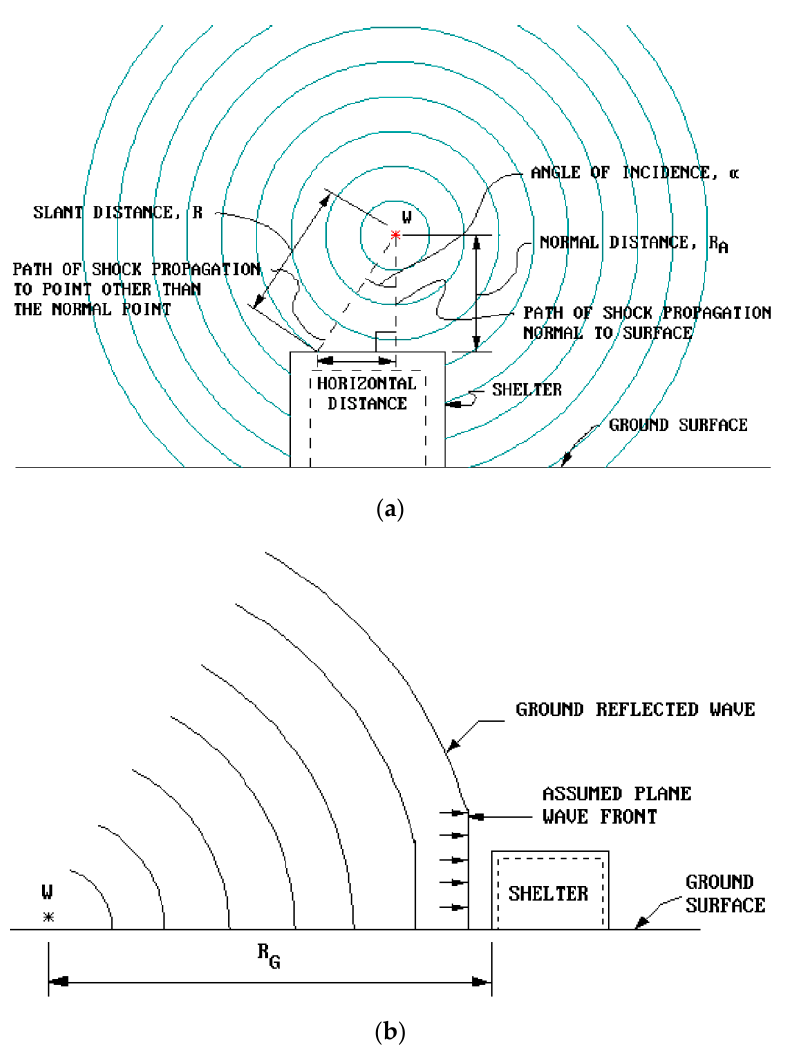
Figure 1. Classification of burst according to the position of detonation [15]: ( a ) Free-air burst; ( b ) Surface burst.